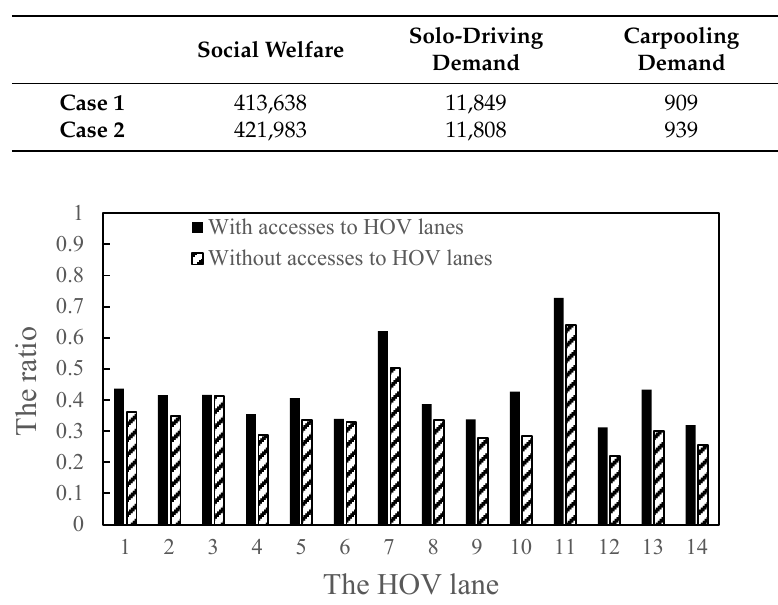
Figure 2. Ratio of flow on the HOV lane to the capacity versus the HOV lane.